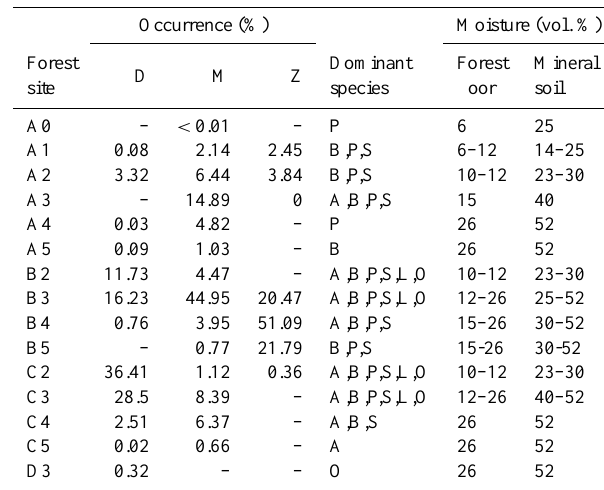
Table 1. Initial distribution of different forest sites and some their characteristics. Occurrence means the portion of total area that is covered by the certain forest site, for Dankovskoe (D), Man- turovskoe (M) and Zheleznodorozhnoe (Z) forest area. Dominant species means the species occurring on certain forest site: A – Eurasian aspen ( Populus tremula L.), B – silver birch ( Betula pen- dula Roth), P – Scots pine ( Pinus sylvestris L.), S – Norway